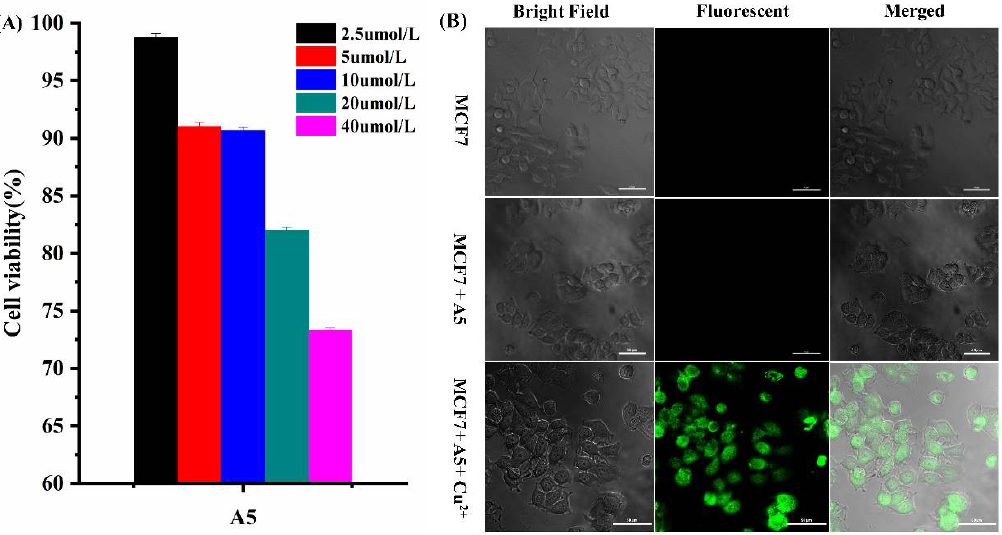
Figure 6. ( A ) MTT assay of MCF-7 cells in the presence of different concentrations of A5 (2.5 μM; 5 μM; 10 μM; 20 μM; 40 μM). ( B ) Bioimaging of MCF-7 cells following incubation with A5 (40.0 μM) in the absence and presence of Cu 2+ (40.0 μM).